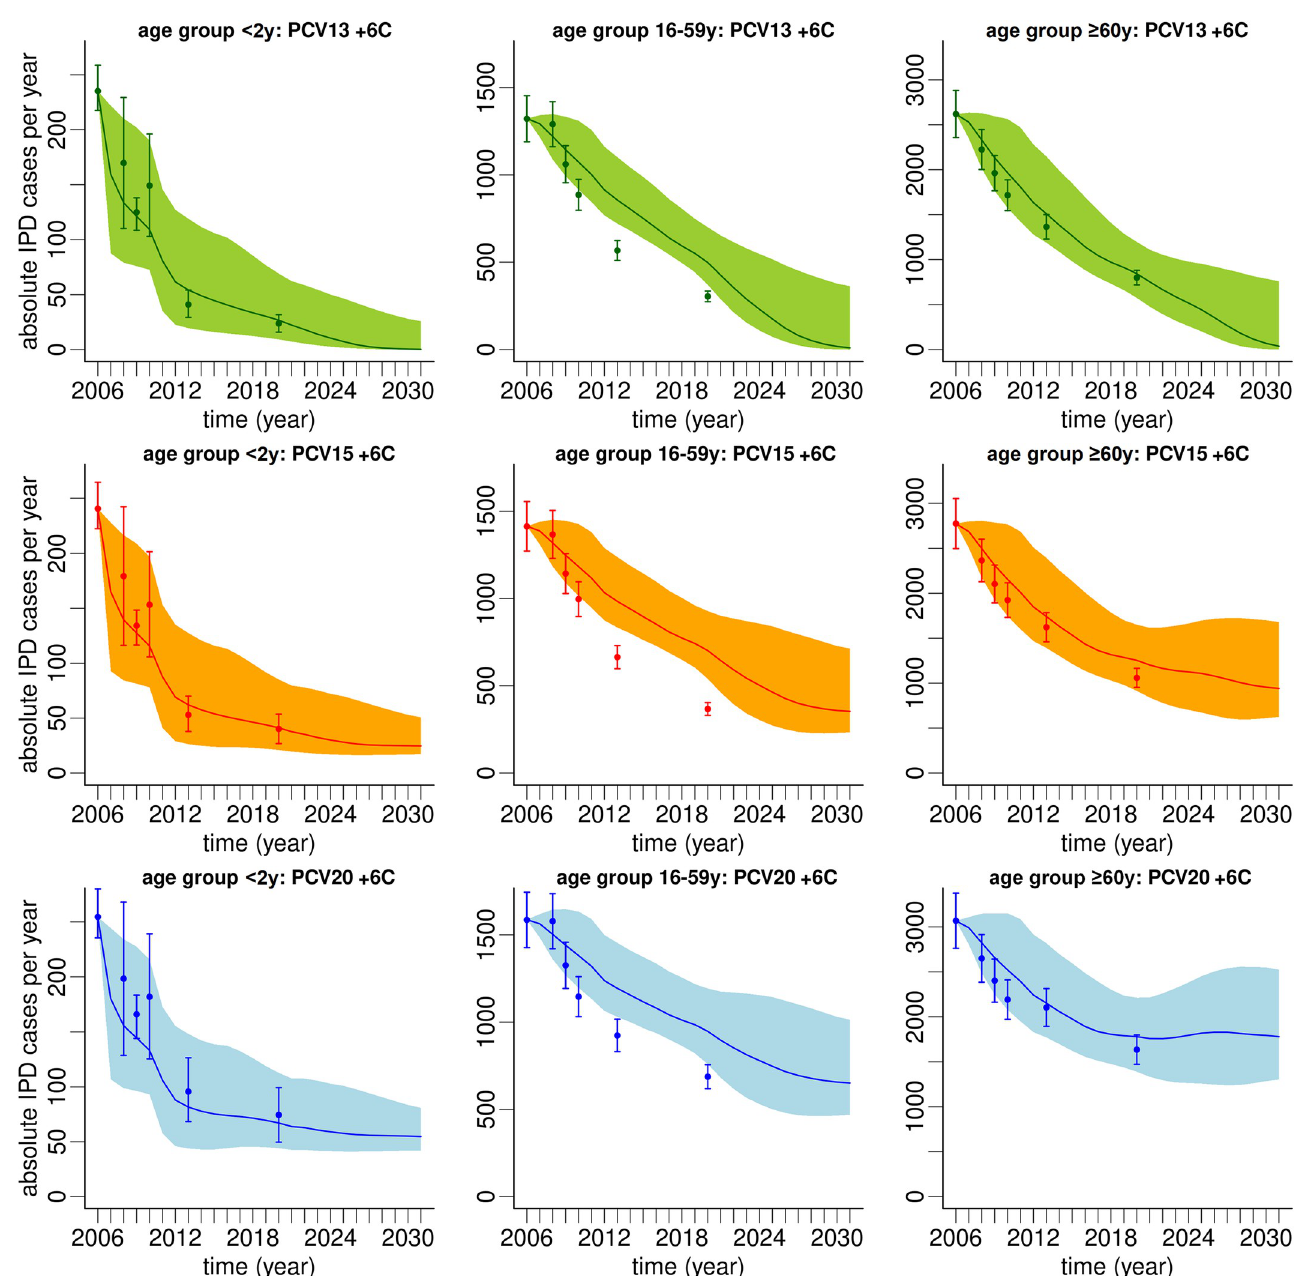
Fig 7. Prediction of absolute IPD cases per year from 2006 to 2031 in Germany for three different vaccine serotype groups (PCV13, PCV15, PCV20; rows) and three age groups ( < 2y, 16-59y, � 60y; columns). In this figure, vaccine serotype groups are defined additively: PCV13 (green) is defined as the sum of G 1 (PCV7), G 2 (PCV13 non-PCV7–3 +6C), and G 3 (serotype 3 only). PCV15: G 1+ G 2+ G 3+ G 4(orange), PCV20: G 1+ G 2+ G 3+ G 4+ G 5 (blue). Serotype 6C is additionally included in each group, because it was included in the G 2 group (Table 1). As in Fig 6, age group 16-59y combines two (16-44y, 45-59y) and age group � 60y combines three (60-74y, 75-84y, � 85y) age groups of the model. Data points (reported IPD cases in Germany multiplied by year-specific underreporting factor) are depicted as filled circles with 95% CIs. Average model predictions are shown by lines with shaded 95% prediction intervals accounting for sensitivity of the model